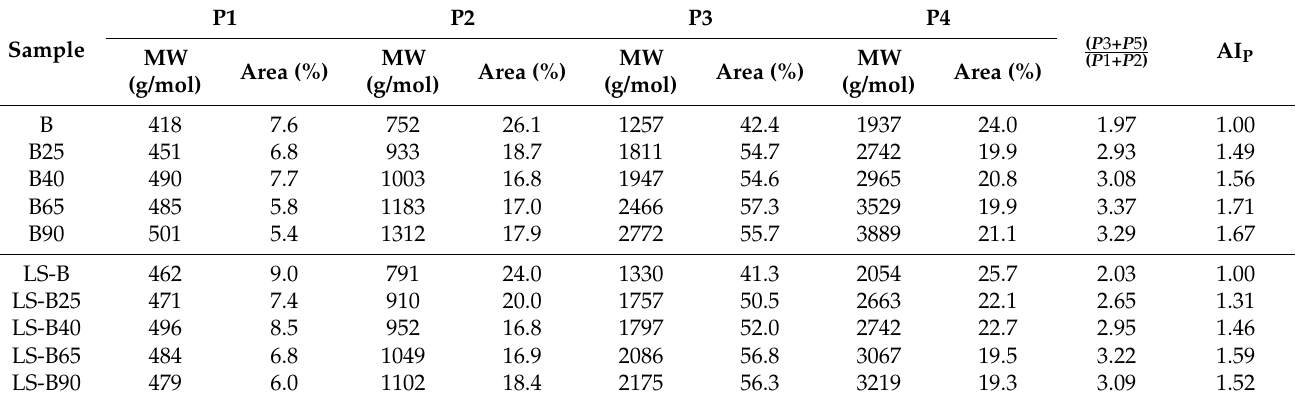
Figure 10. Deconvolution in four Gaussian peaks of the AMWD for B25 binder. Table 5 summarises the molecular weight (g/mol) corresponding to the peak and the relative quantities of the four populations, calculated as the integral of the relative Gaussian peak. Table 5. Percentage area of the P1–P4 populations and related aging index for the B and LS-B